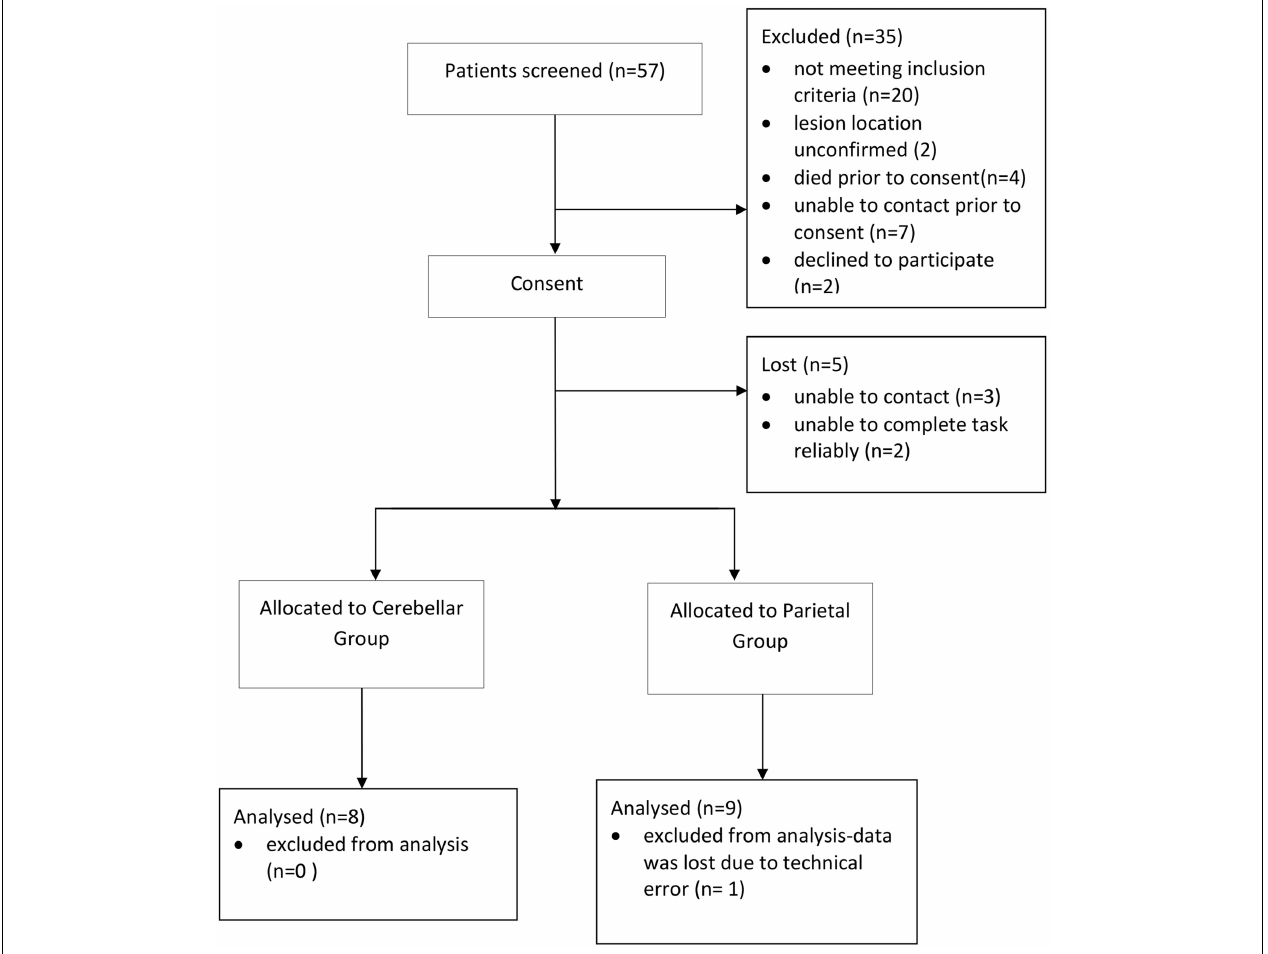
FIGURE 2 | Recruitment flow diagram